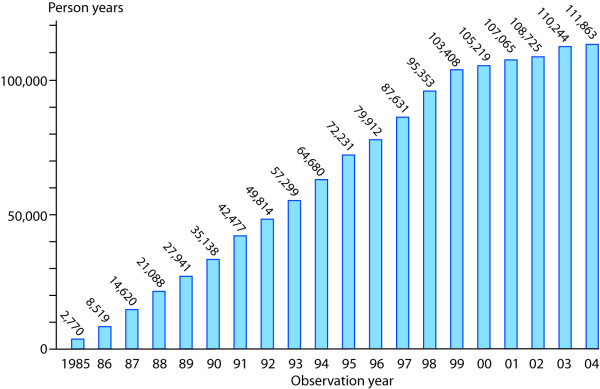
Person years during the observation period. The number of person years for each year increased gradually until 1999 when the at-risk population included the complete age cohort between 0 and 15 years.